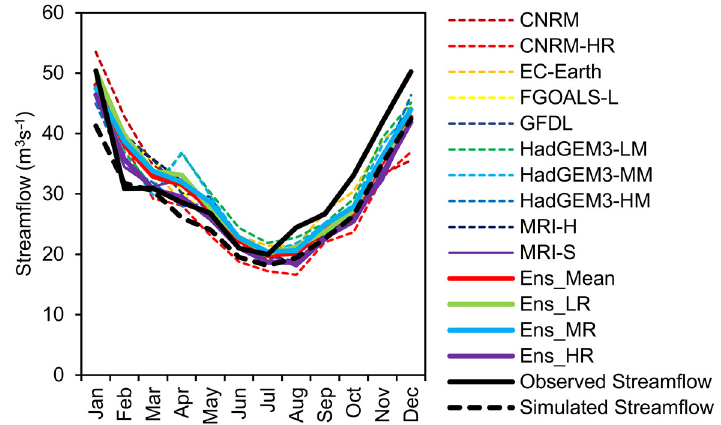
Figure 4. Comparison of mean monthly streamflow from observation, SWAT-simulated with gauge and corrected CMIP6 HighResMIP projections at the Rantau Panjang station from 1985 to 2014.